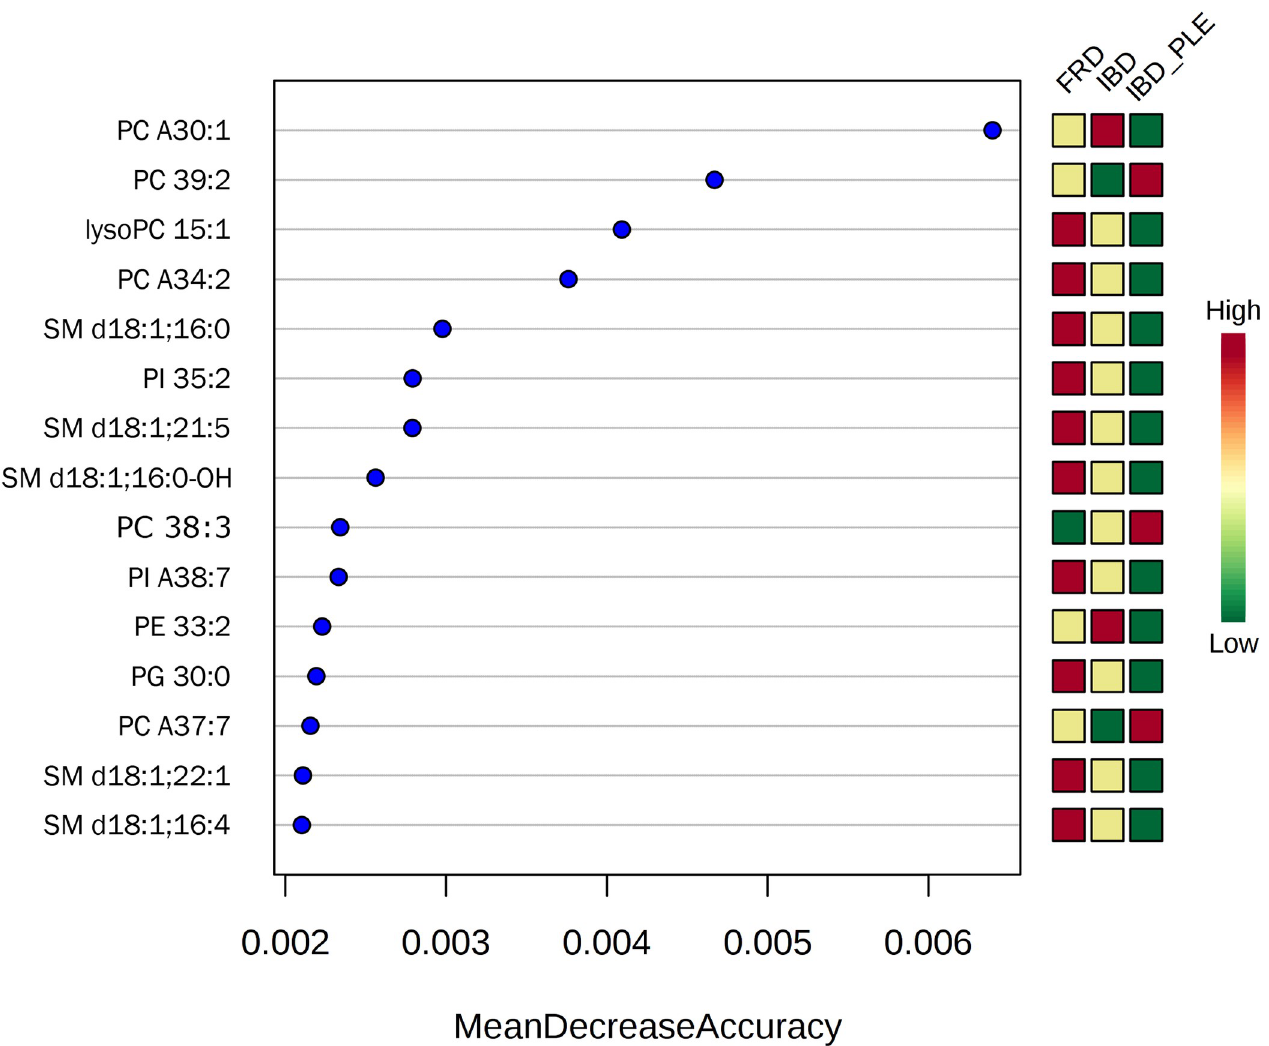
Fig 5. Random forest analysis of phospholipids and their association with disease category. Fifteen phospholipids with the highest discriminatory power between the disease categories are presented. The abundance of the phospholipids is color-coded, with red boxes representing a high abundance and green boxes representing a low abundance of a given phospholipid. PC, phosphatidylcholine; SM, sphingomyelin; PI, phosphatidylinositol; PE, phosphatidylethanolamine; PG, phosphatidylglycerol. ’A’ indicates an ether species; the XX:y notation specifies the total number of carbon atoms in the radyl chains (’XX’) followed by the number of unsaturation (’y’); for sphingolipids, a sphingosine (d18:1) backbone was assumed.